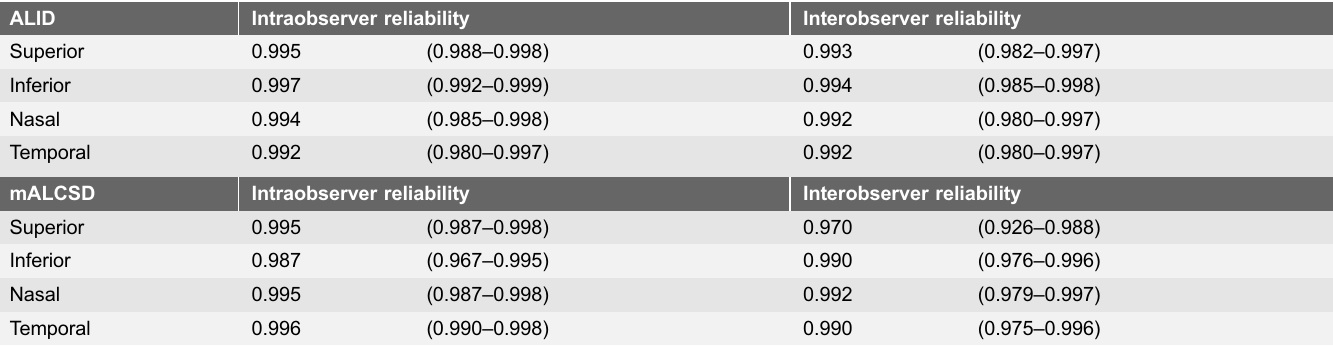
Table 3. Inter and intraobserver reliability of measuring ALID and